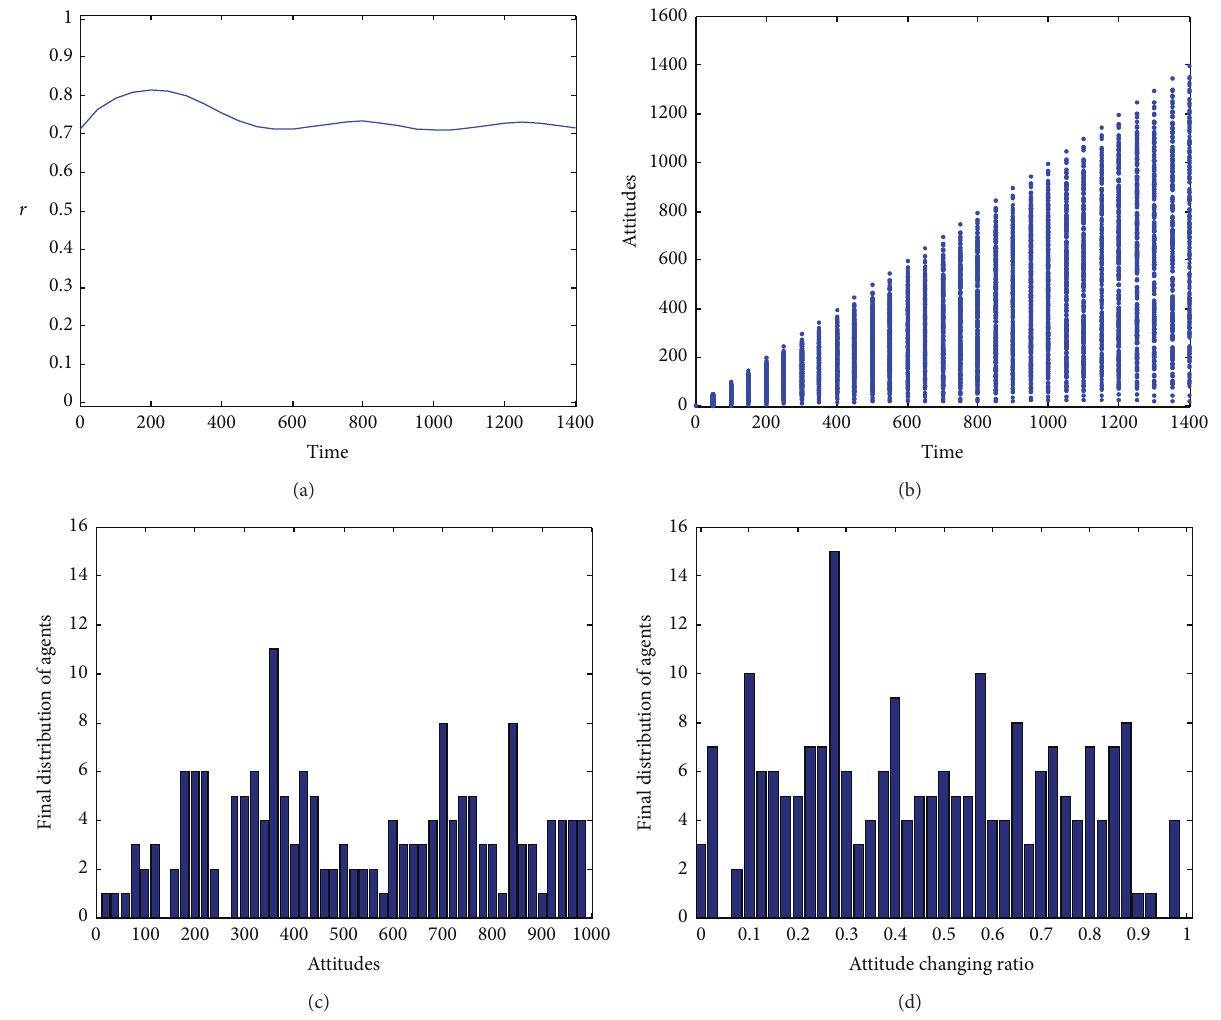
Figure 10: The simulation results with heterogeneous parameters, where 𝛼 and 𝑤 satisfy the normal distribution whose mathematical expectation is 0.5 and variance is 0.17. (a) is the subfigure which shows synchronization criterion 𝑟 changes with time; (b) is the subfigure which shows group attitudes 𝑥(𝑡) versus time; (c) is the histogram of the final distribution of agents versus group attitudes 𝑥(𝑡) ; (d) is the histogram of the final distribution of agents versus attitude changing ratio ̇𝑥 𝑖 (𝑡)